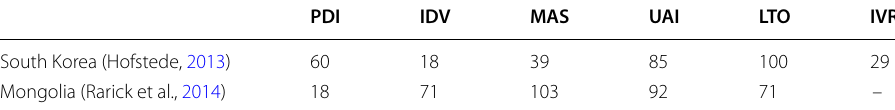
Table 1 Cultural scores for South Korea and Mongolia from preceding